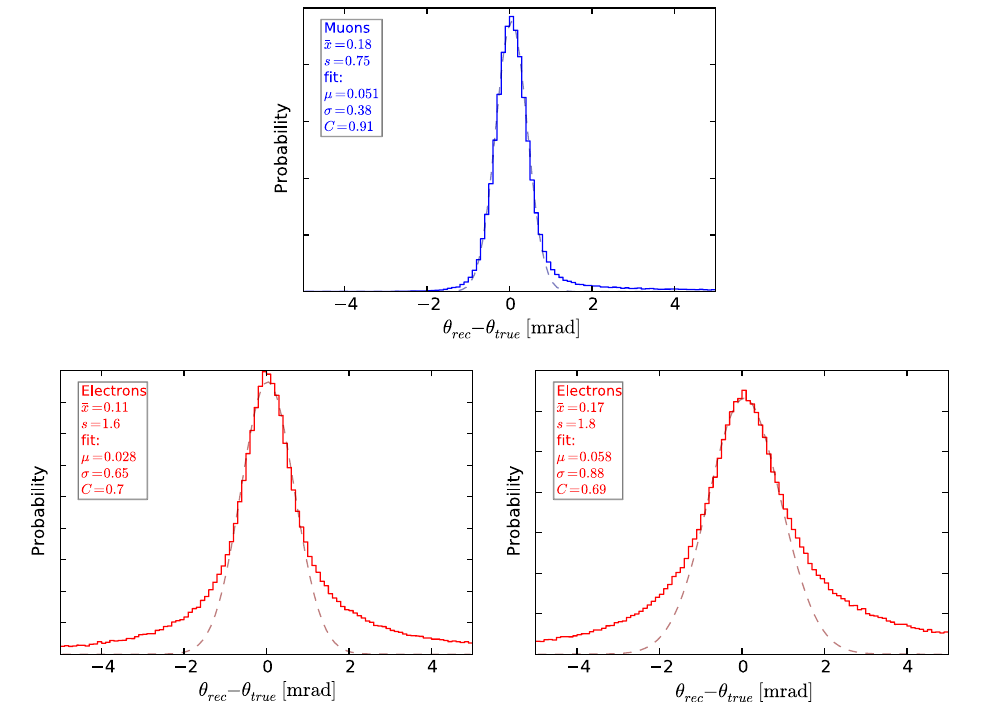
FIG. 7. Detector angular resolution for muons (top) and electrons (bottom left: 25 GeV; bottom right: 10 GeV neutrino factory) for leptonic events. Gaussian fits are shown with dashed lines. The sample mean, standard deviation, and fit parameters are shown in the upper left corners.